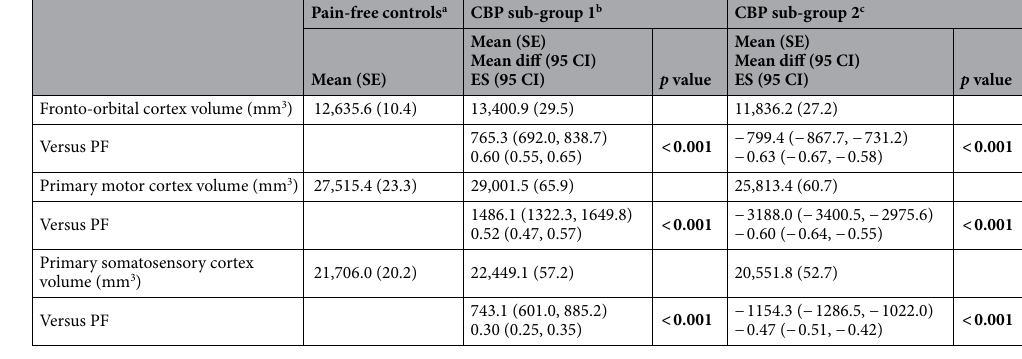
Table 5. Results of the Analysis of Covariance (ANCOVA) sub-groups derived from brain structure variables. Data are presented as adjusted mean (standard error). Adjusted mean differences and 95% confidence interval (95 CI) are reported. Effect sizes and 95% confidence intervals were calculated using standard formulae. All data were adjusted for age and sex. p value s were adjusted for multiple comparisons using Tukey HSD method. PF pain-free, 95 CI 95% confidence interval, ES effect size. Significant values are in [bold]. a Pain-free individuals (n = 14,927; 78.2%). b CBP sub-group 1: high fronto-orbital and primary motor cortex volumes (n = 1917; 10.1%); c CBP sub-group 2: low fronto-orbital and primary motor cortex volumes (n = 2239;